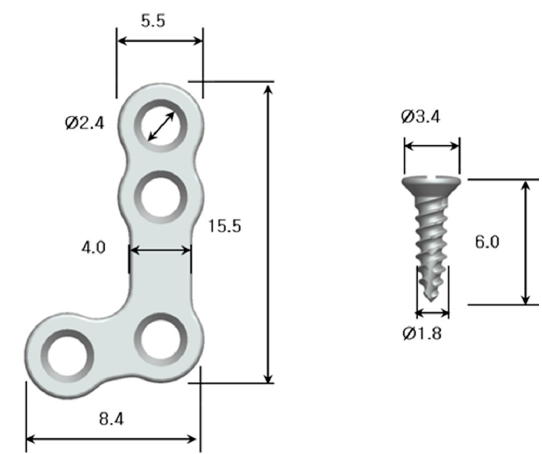
Figure 1. Dimensions and design of the ZK60 plates and screws.